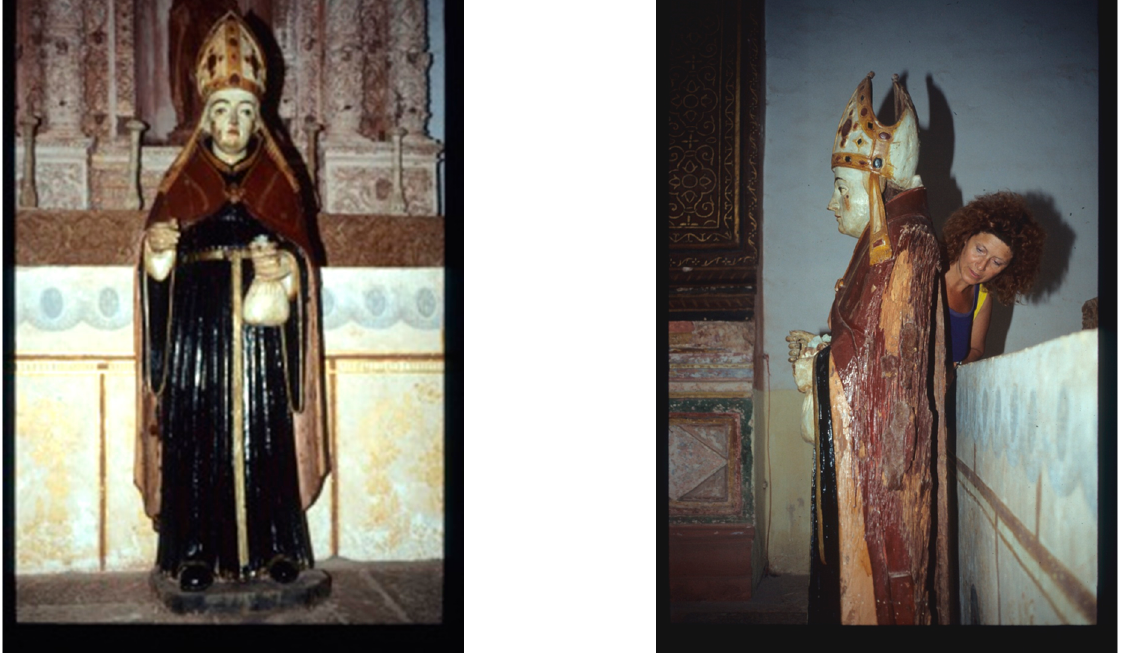
Figure 7. Indo-Portuguese statue, polychrome teak, h.1.57 cm., Church of St. Francis, 17th century, Goa.